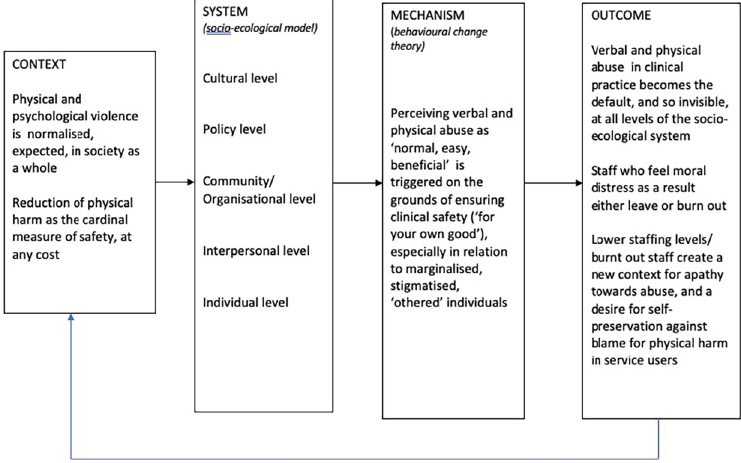
Fig 11. Logic model for contexts and mechanisms integrated with the socio-ecological-behavioural approach.